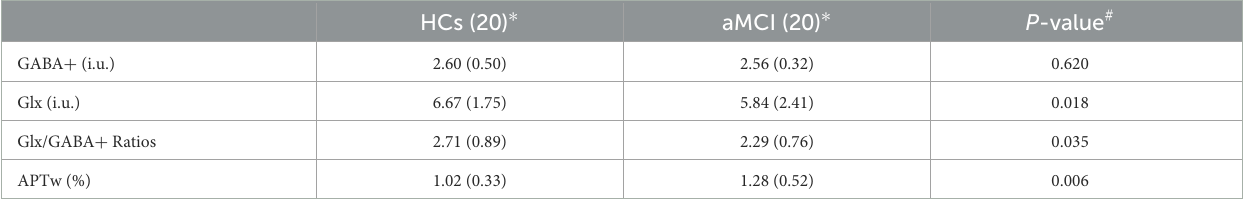
TABLE 3 Difference of right hippocampal metabolites between patients with HCs and patients with aMCI. HCs (20) ∗ aMCI (20) ∗ P -value # GABA + (i.u.) 2.60 (0.50) Glx (i.u.)